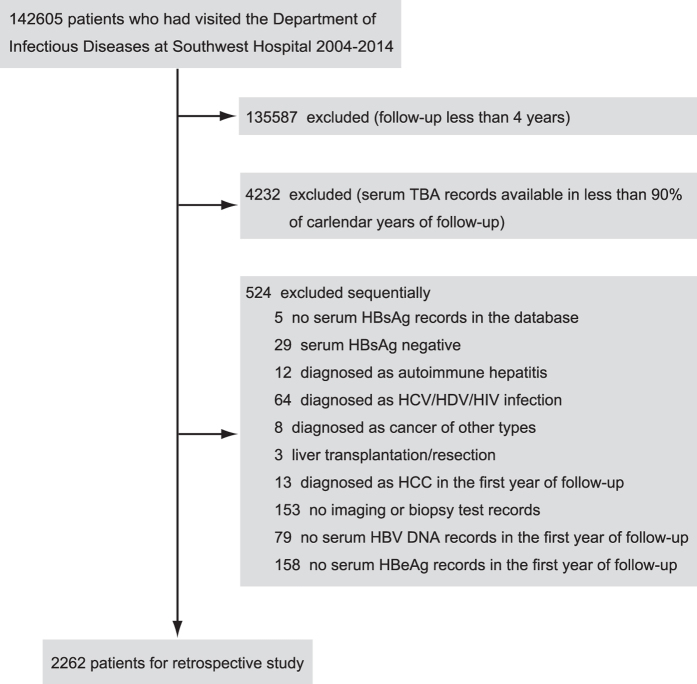
Retrospective study cohort.